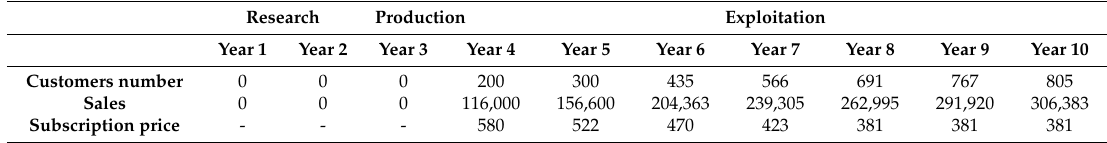
Table 2. Forecasting sales prices and